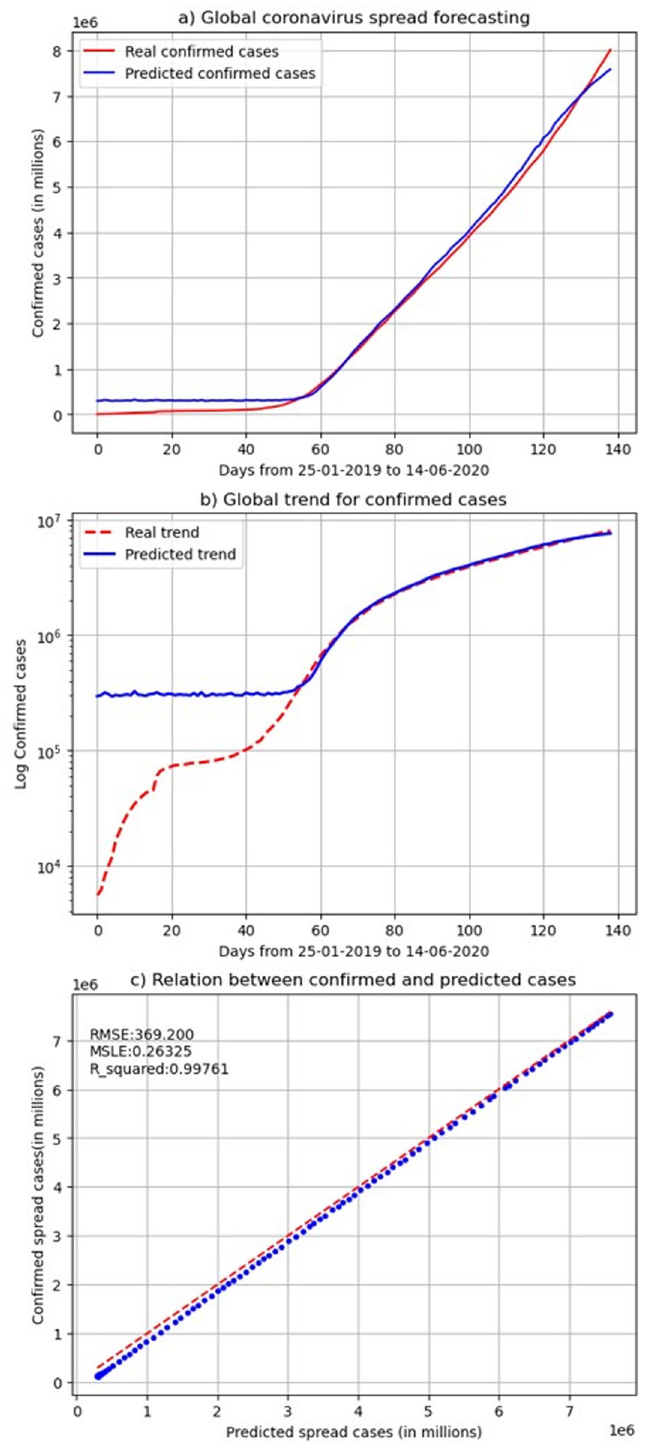
Fig 10. The total confirmed cases globally and the sum of the predicted cases at a country level (linear and logarithmic scales).